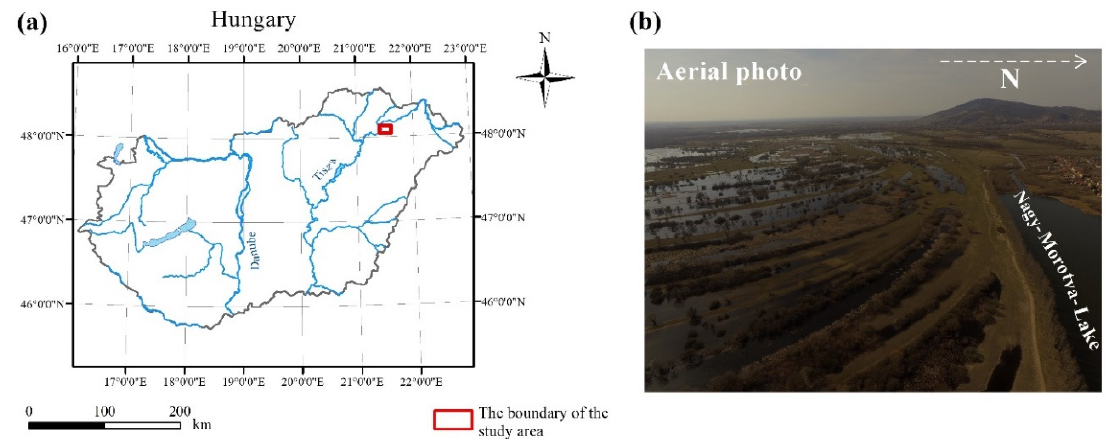
Figure 1. ( a ) The location of the study area; ( b ) a photo from the studying area showing point bar and swale series, captured by drone by Csaba Albert Tóth, 2017.